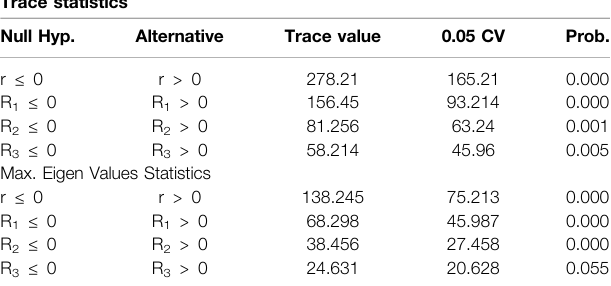
TABLE 5 | Outcomes of Trace and Eigen Values tests. Trace statistics Null